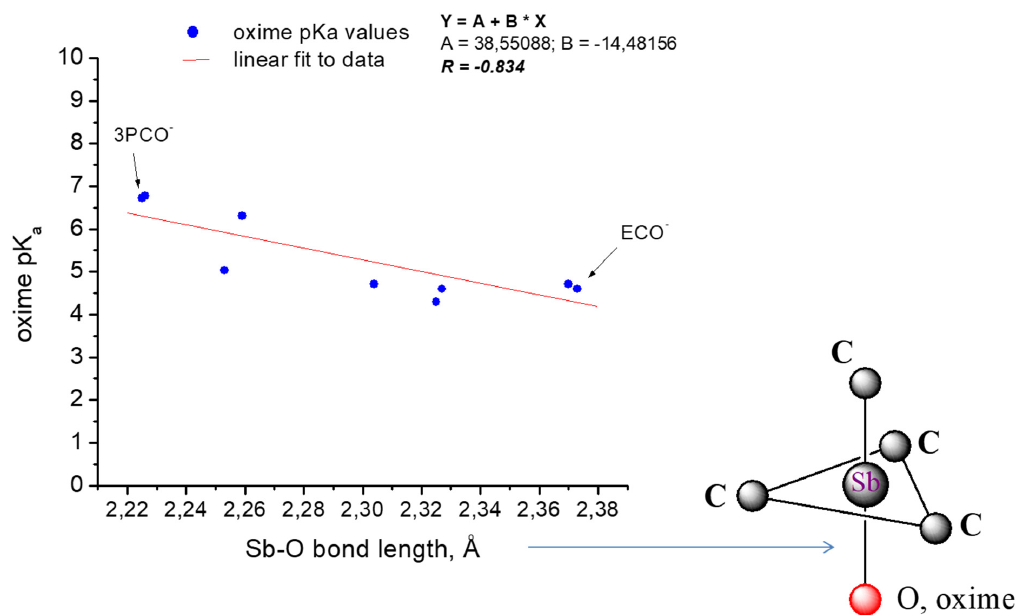
Molecules 2022 , 27 , x FOR PEER REVIEW Figure 5. Observed trend in geometry of the antimony(V) environment and acidity of coordinated bond to cyanoxime moiety: Sb–O bonds vs. acidity of the cyanoxime.